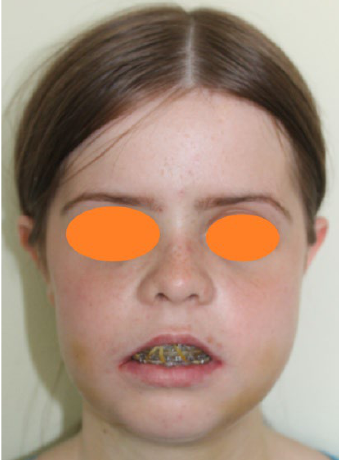
Figure 4. Immediate post-surgical photographic examination. Facial aspect: frontal view with occlusal splint.